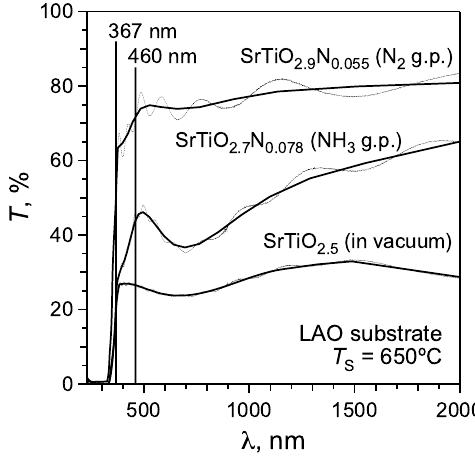
Figure 6. Optical transmittance spectra of the films grown on LaAlO 650 °